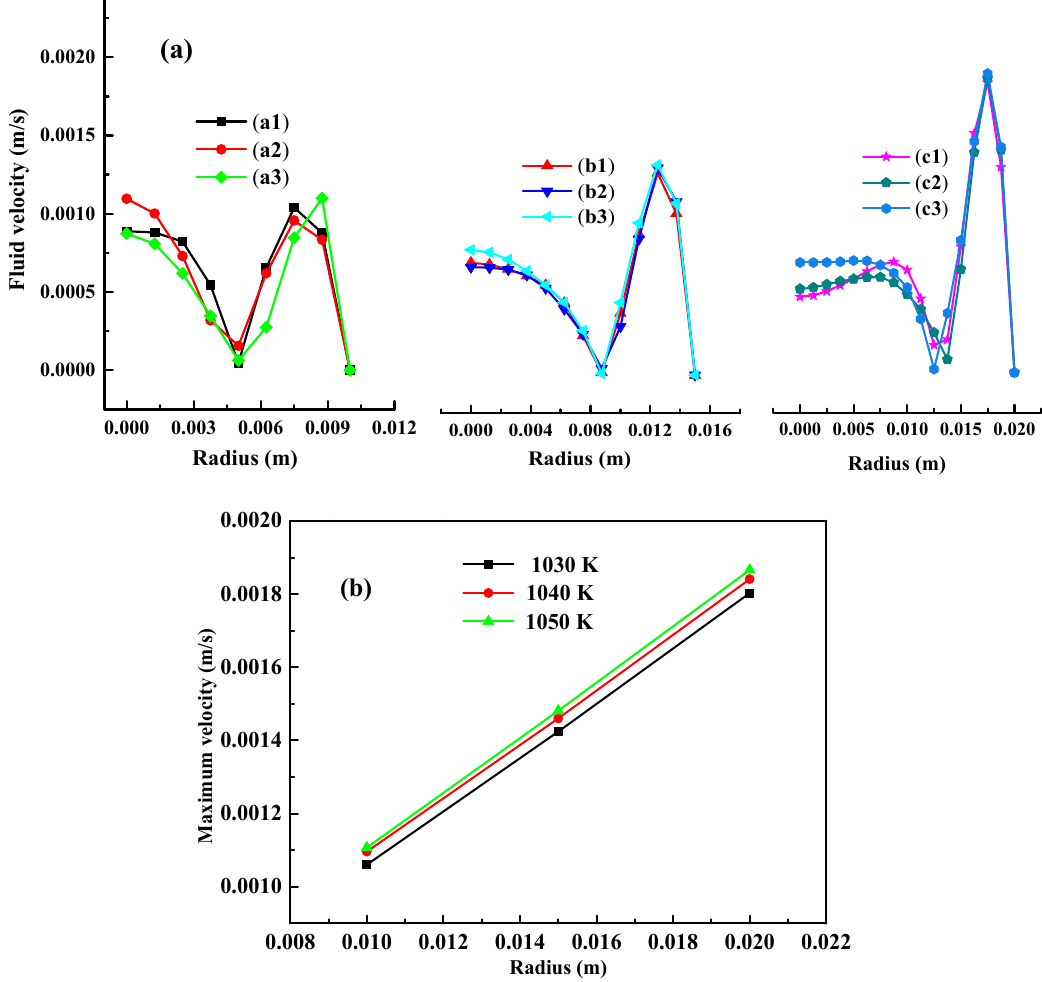
Figure 7. ( a ) The distribution of flow velocity along the radius of the crucible and ( b ) the maximum flow velocity variations with the crystal radius and the maximum temperature of the furnace. The melting zone is 0.08–0.12 m away from the crucible bottom.